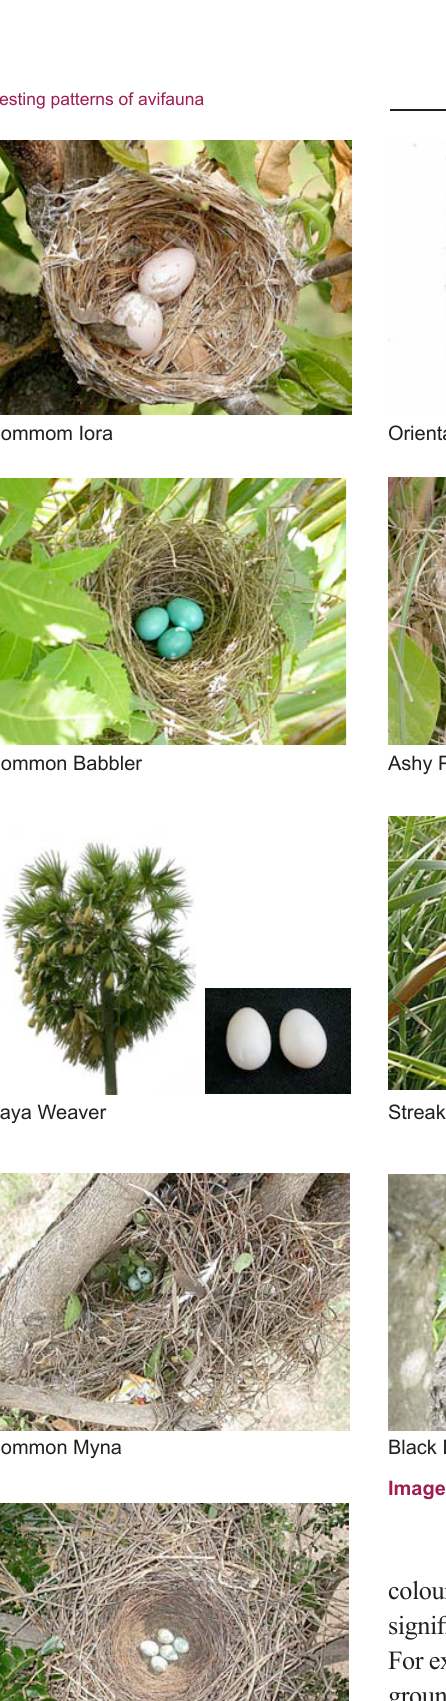
colour (Kilner 2006). Lack (1968) stated that egg colour had no taxonomic significance, but that did show a relationship with the type of nesting-site. For example the hole nesting species tended to have immaculate white eggs, ground nesters surrounded by vegetation laid eggs of obscured brown, gray or olive, those nesting in forks of tree branches had eggs with blotches or shadow-marks on a white or blue background.